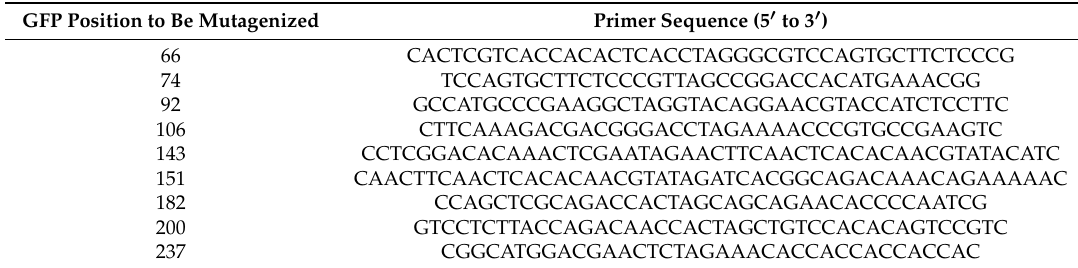
Table A1. Sequences of mutagenic primers for generating amber stop codon-containing GFP reporter